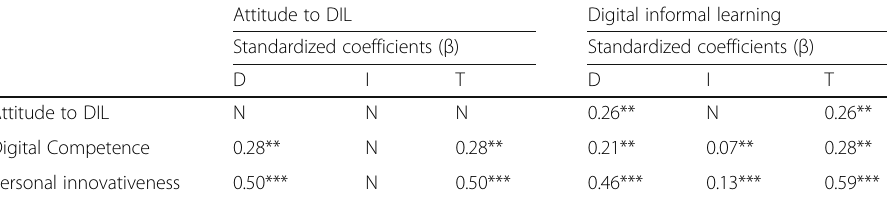
Table 7 Effects analysis results Attitude to DIL Digital informal